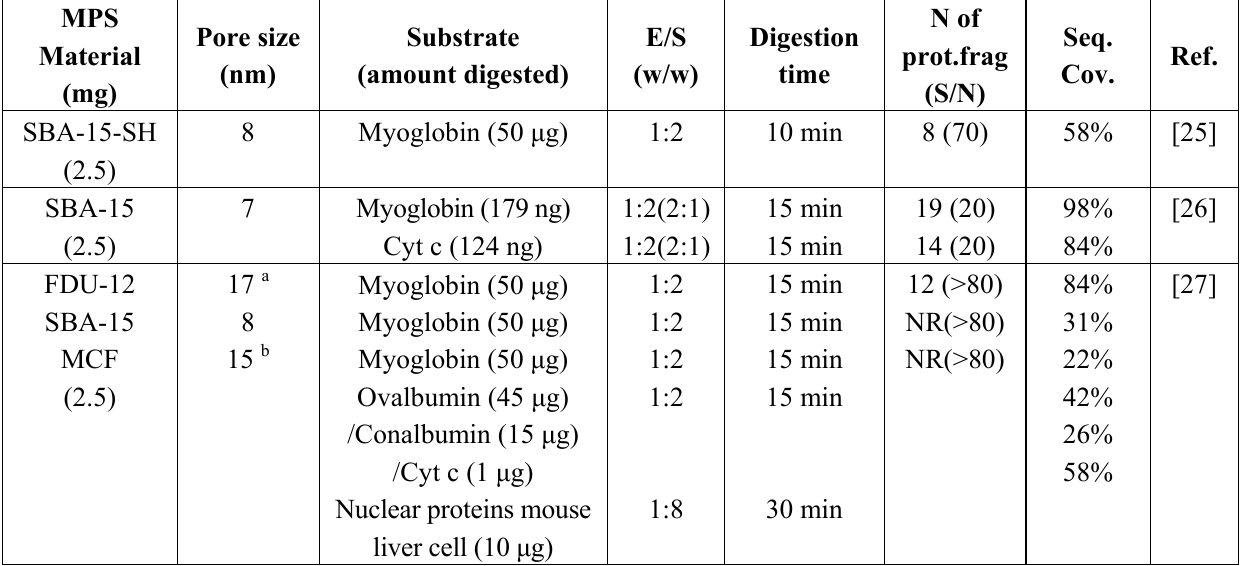
Table 2. A comparison of mesoporous materials performances for in mesopore protein